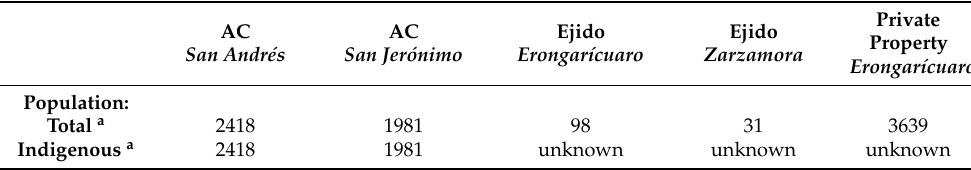
Table 1. Characteristics of localities in study region.